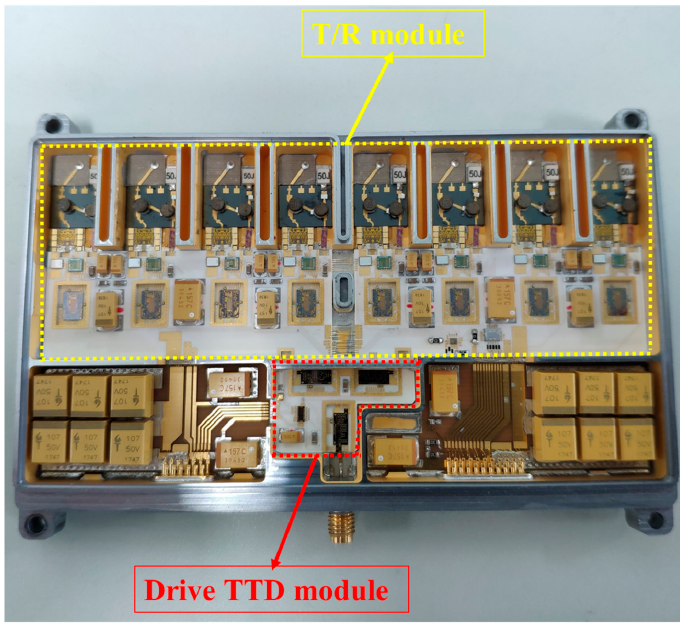
Figure 3. A photo of the 8-channel T/R module with 7-bit TTD.